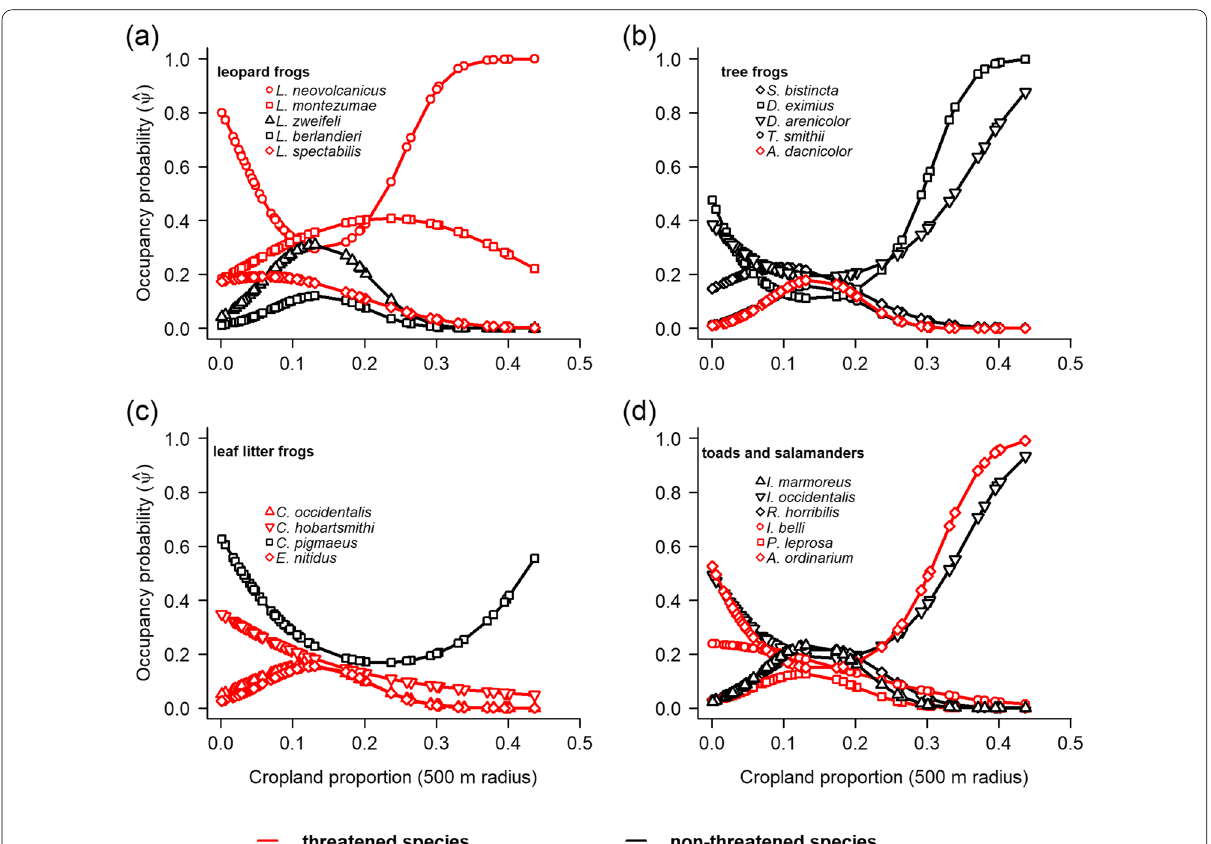
Fig. 3 Linear and quadratic effect of cropland proportion on occupancy of 20 detected amphibian species. The figure shows the response of each species in the following categories a leopard frogs, b tree frogs, c leaf litter frogs and d toads and